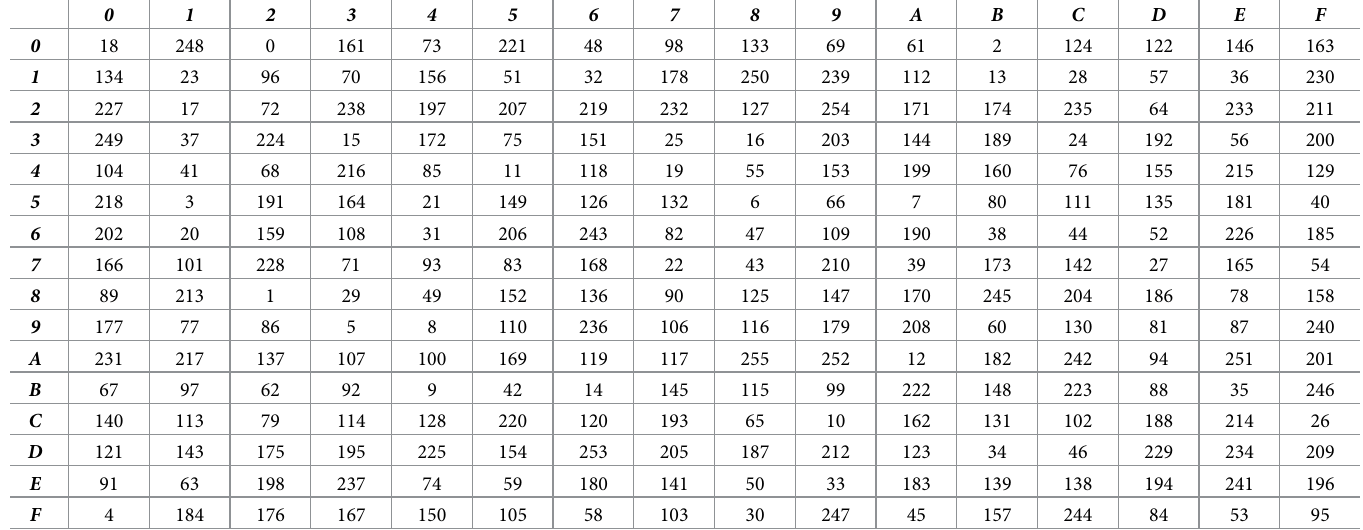
Table 8. Proposed S-box (S7) in 16 × 16 matrix form—Generated with T 7 .